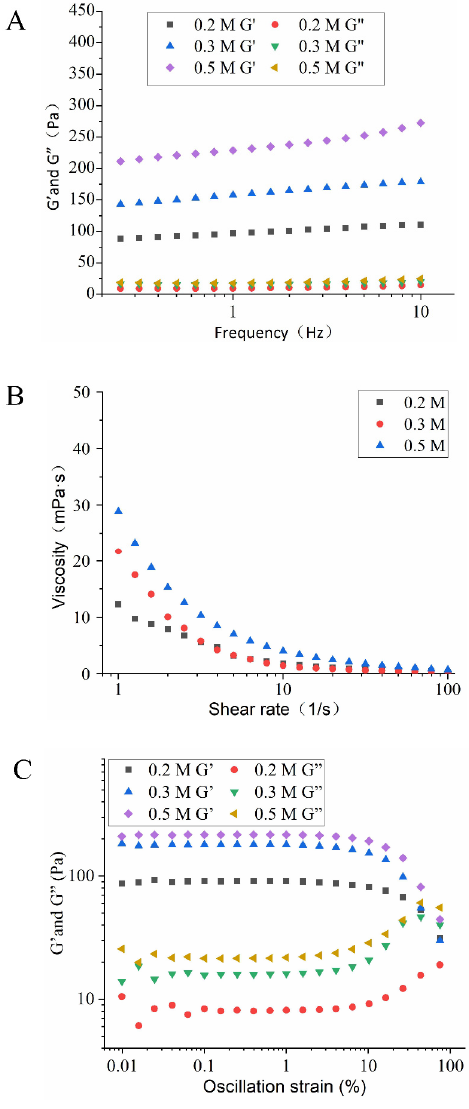
Figure 8. Rheological behavior of the HIPEs with 0.8 ϕ and 3.0 wt% EYGs at different NaCl ionic strength. Storage (G ′ ) and loss (G ″ ) moduli of the HIPEs as a function of frequency ( A ). Apparent viscosity of the HIPEs as a function of shear rate ( B ). G ′ and G ′′ of the HIPEs as a function of oscillation strain ( C ).